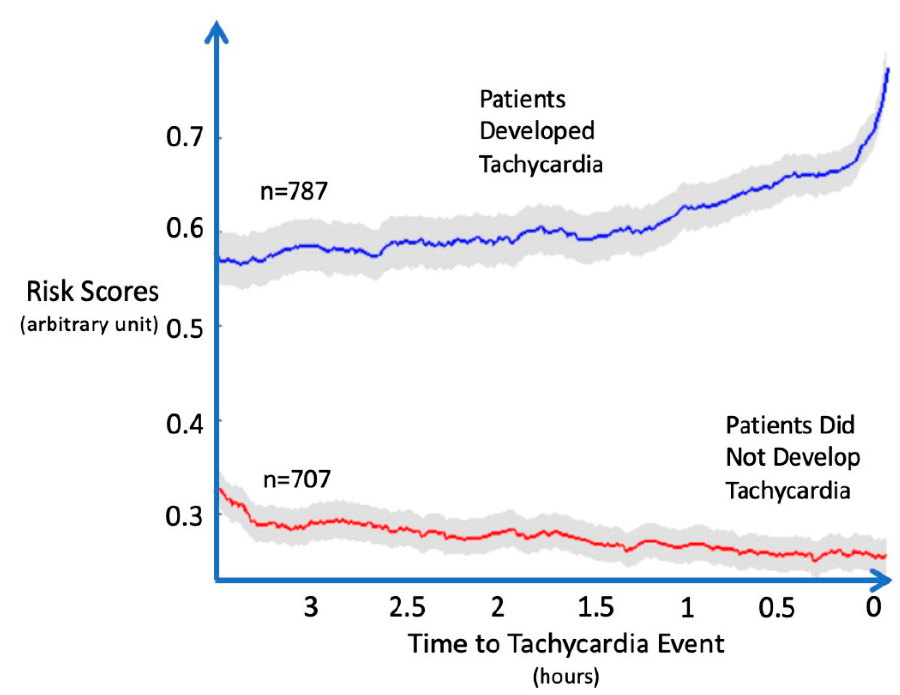
Figure 1. Model prediction of initial tachycardic episode using external control data matched for every episode of tachycardia. Comparison of a model trained on MIMIC-II data to identify an initial episode of tachycardia (heart rate (HR) > 130/min) in an external validation cohort from that same database. Results are shown as risk score changes over time as the future tachycardic and non-future tachycardic (control) groups move toward the event. The control group’s time series data were time-matched to correspond to the future tachycardic group’s time in the ICU. Data derived from Yoon et al.